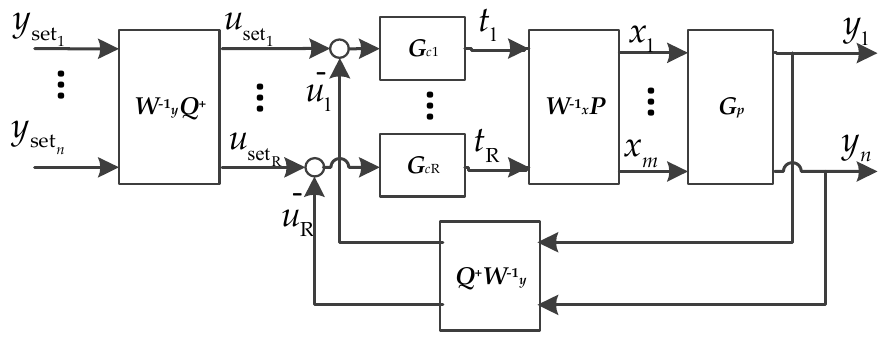
Figure 1. Dynamic PLS control framework proposed by Kaspar and Ray.